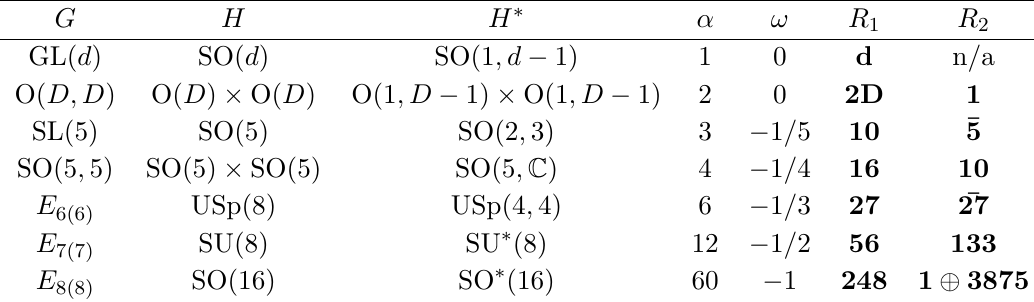
Table 1 . The vital statistics of ordinary geometry, DFT and ExFT. The (generalised) metric lives in G=H (Euclidean case) or G=H (cid:3) (Lorentzian case) [68], (generalised) vectors are valued in R 1 , and the section condition in R 2 . The intrinsic weight is given by ! = (cid:0) 1 = ( n (cid:0) 2) in ExFT and ! = 0 in